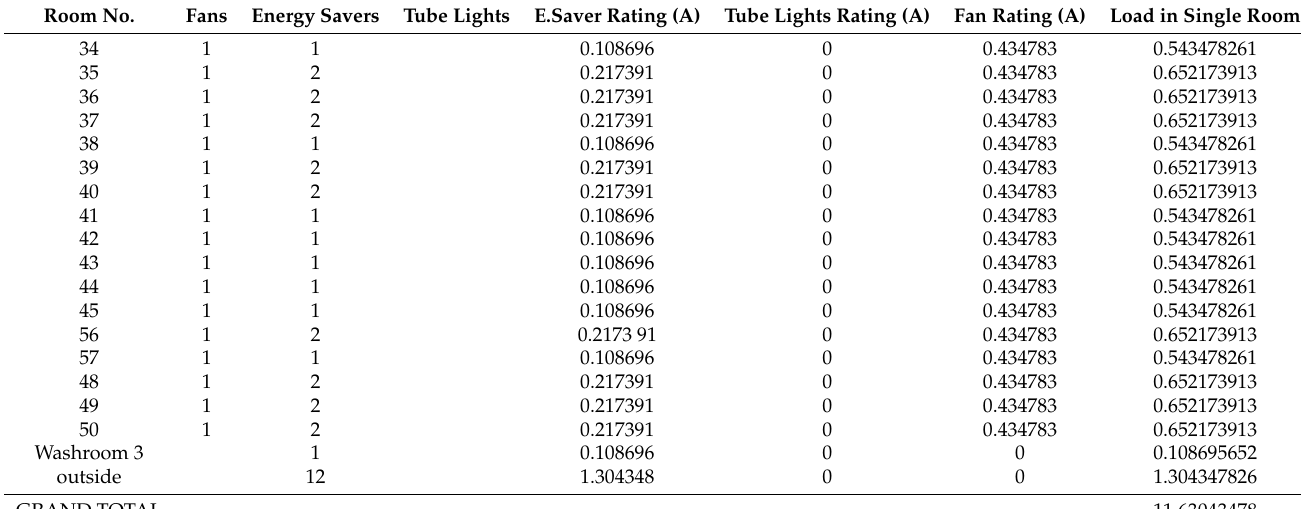
Table 6. Faqir API Hostel (2nd floor) existing load